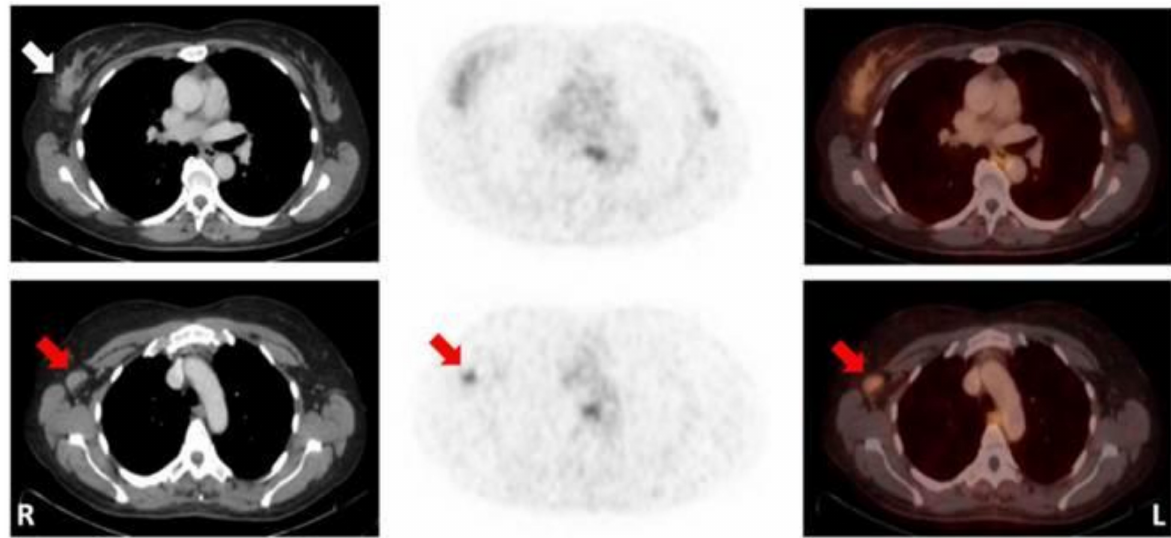
Figure 3. Patient with a mucinous carcinoma of the right breast with low ER/PR-expression. CT (left); 68 Ga-RM2-PET (middle); fusion images (right); primary tumour indicated by white arrow; lymph node metastasis indicated by red arrows. (Figure unmodified from Stykow et al. [79] Creative Commons Attribution 4.0 International